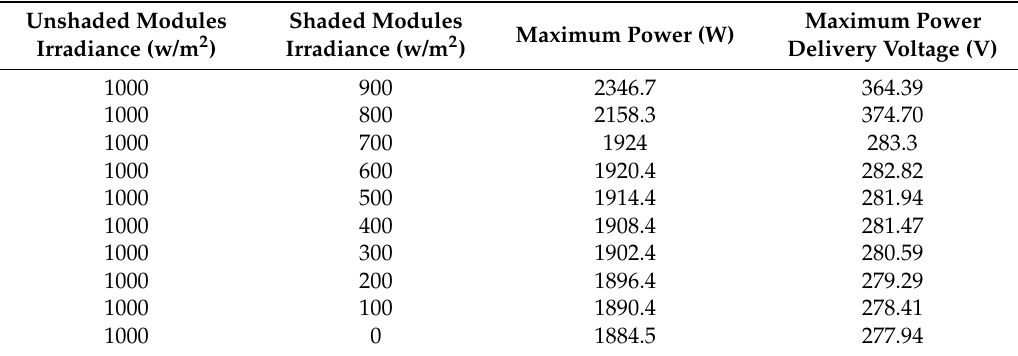
Table 6. Maximum powers of the 4 modules shaded setup.